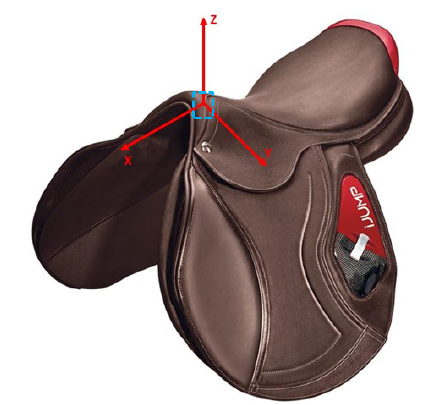
Figure 1. Orientation of the IMU’s axes and sensor location (blue dotted